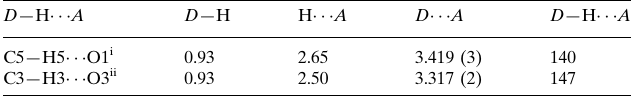
Hydrogen-bond geometry (A˚ , (cid:4)